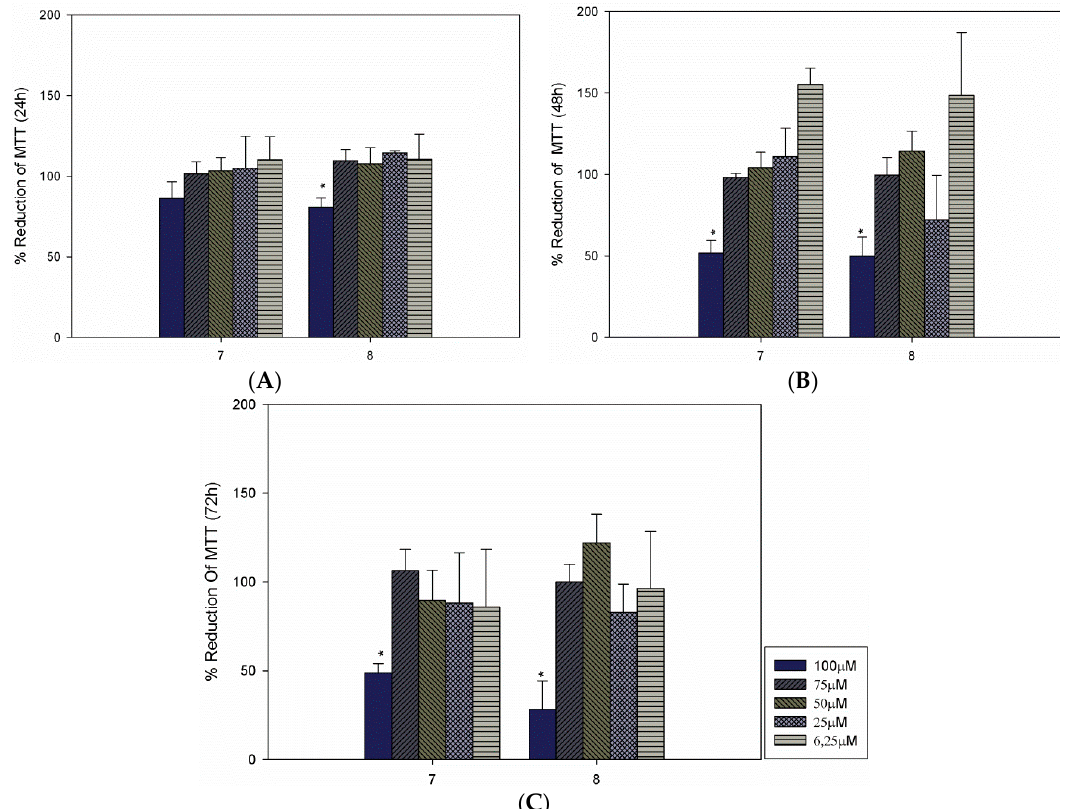
Figure 3. Toxicities of isobenzofuranones 7 and 8 to RAW macrophages. MTT viability assays were performed after 24 h ( A ); 48 h ( B ) and 72 h ( C ) of treatment. The results are presented as the averages and the SDs of three independent experiments that were performed in triplicate. The * indicates significant differences compared with the control at p < 0.05.